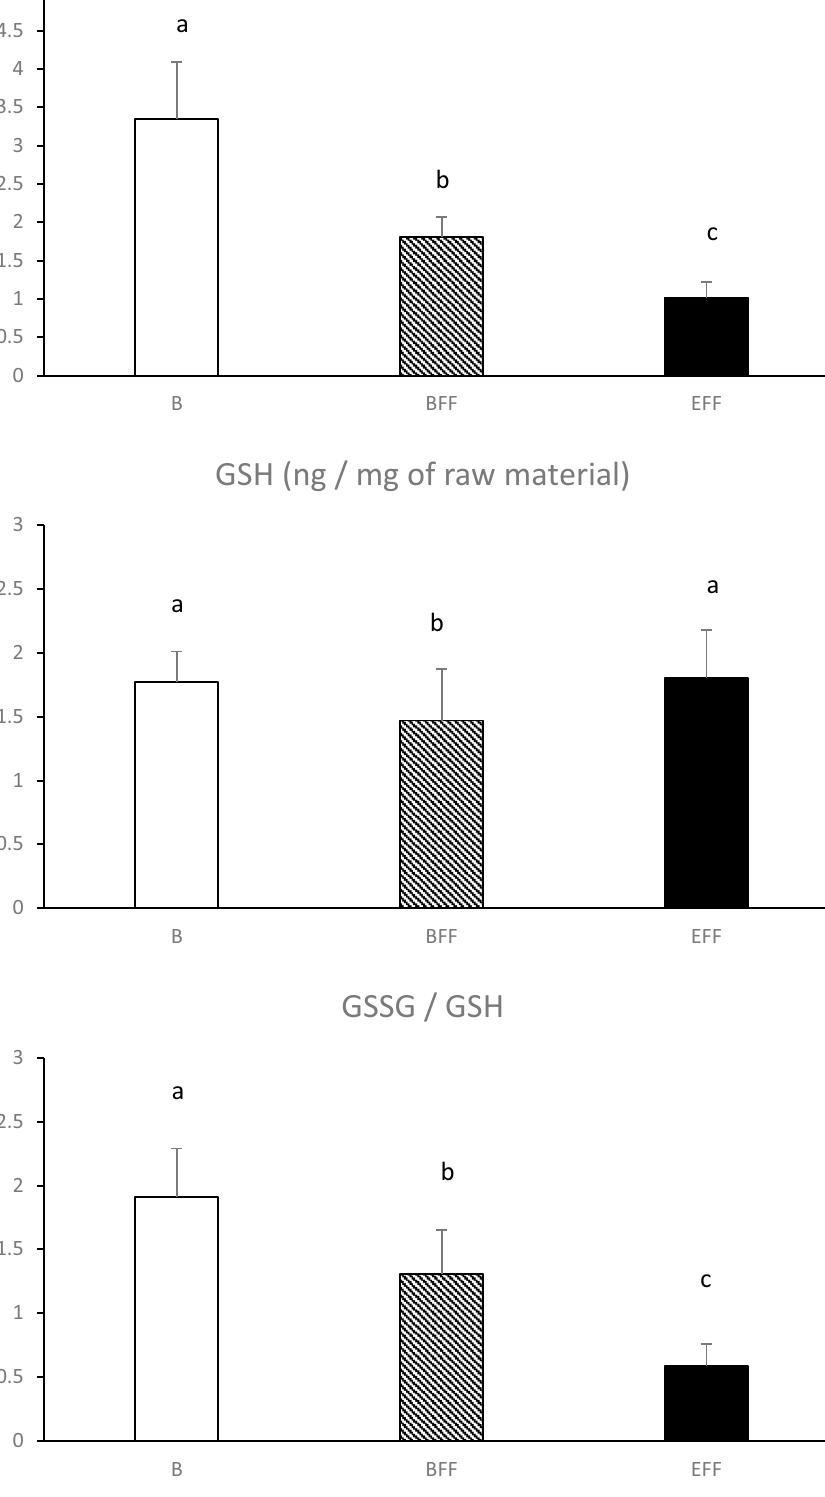
Figure 3. Values of oxidized glutathione (GSSG) and reduced glutathione (GSH) contents in livers collected before (B) or at the beginning (BFF) or at the end (EFF) of the force-feeding period. Values are means ± SD. Bars with different letters differ (p <